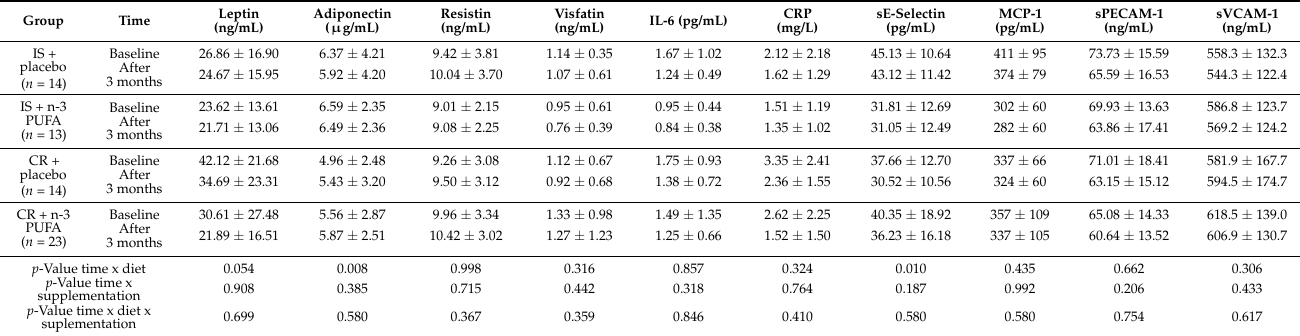
Values are presented as means ± SD. Statistics: analyses were performed with repeated-measures by ANOVA. Abbreviations: CR, caloric restriction; CRP, C-reactive protein; MCP-1, monocyte chemoattractant protein 1; IL-6, interleukin 6; IS, isocaloric diet; sPECAM-1, soluble